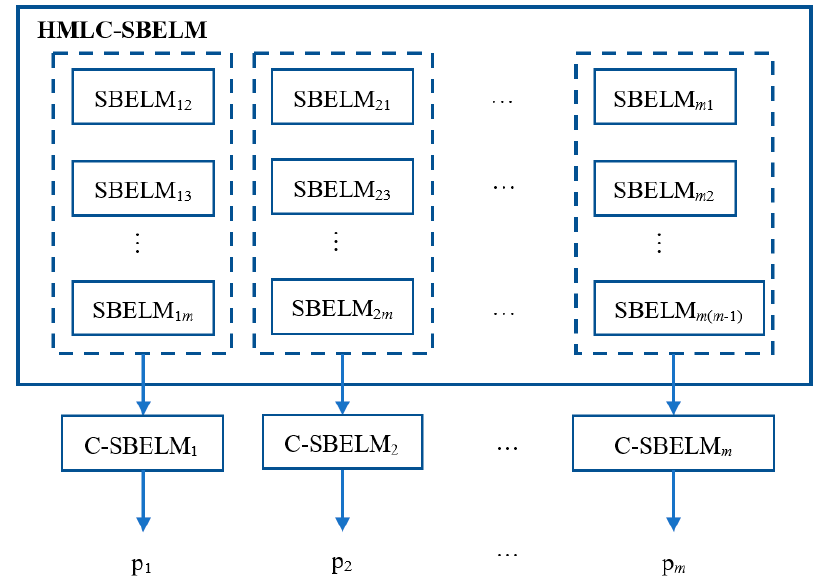
Figure 2. The architecture of model-based on HMLC-SBELM.